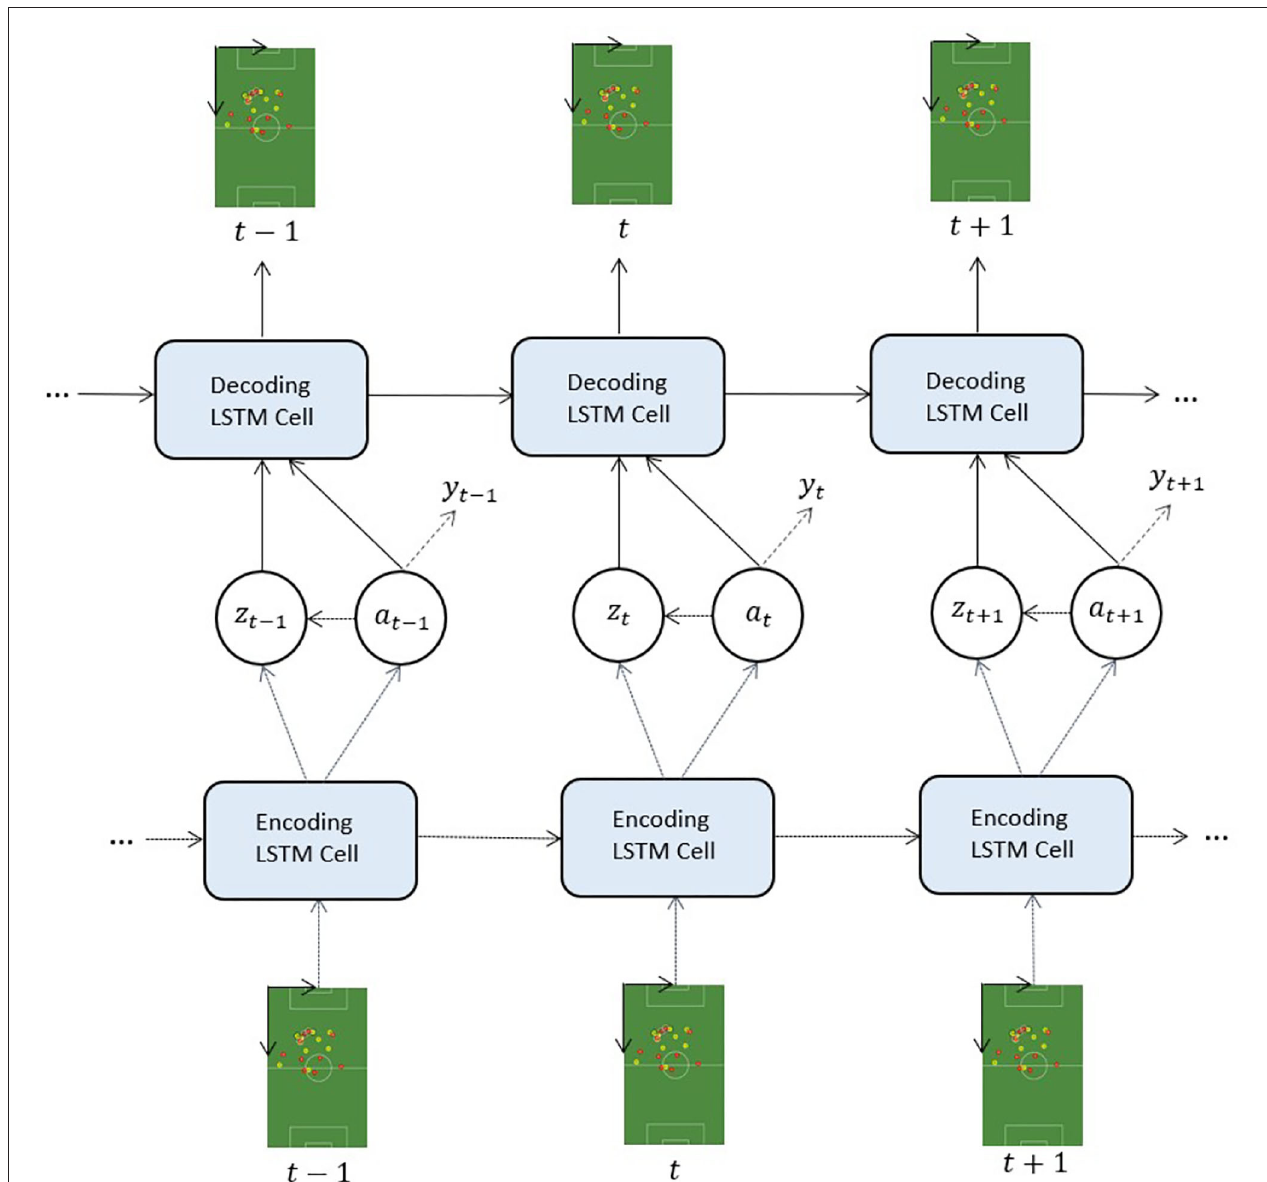
FIGURE 3 | The SeqLabelVAE. Dashed lines indicate modules performing inference, solid lines denote components performing generation, and dotted lines point out the auxiliary